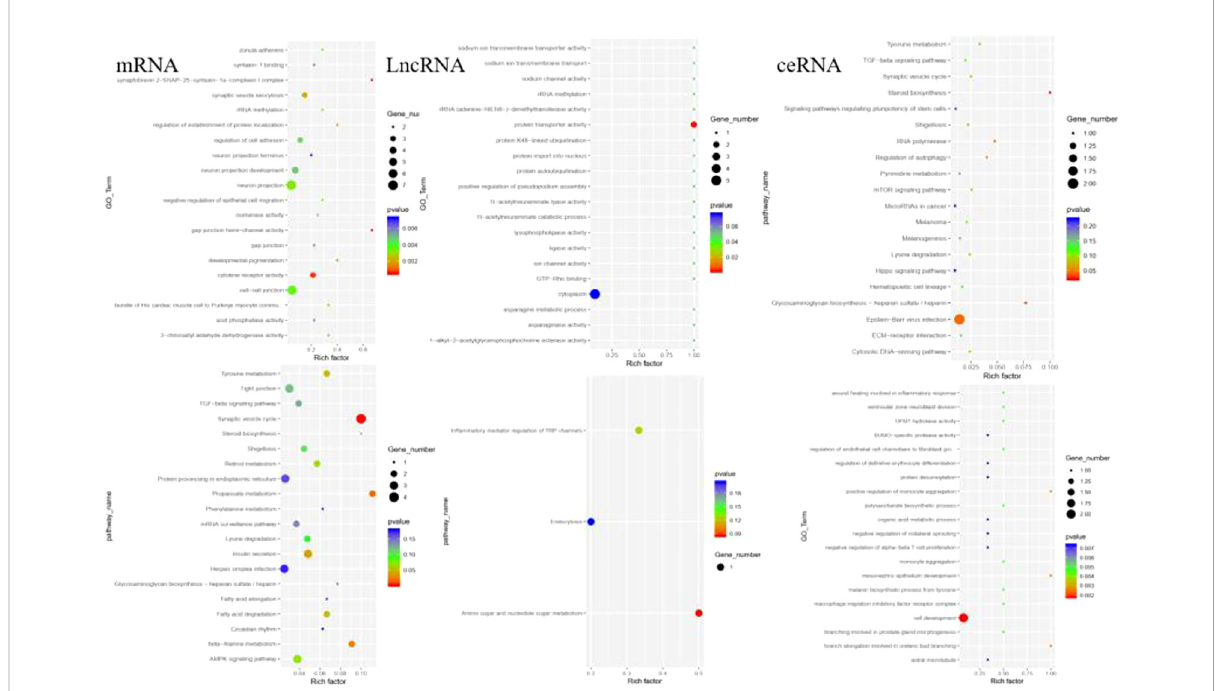
FIGURE 3 GO and KEGG analysis revealed the potential mechanism of DEMs, DELs, and DECs in paclitaxel